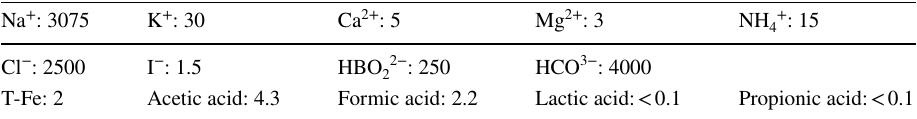
Composition is given in